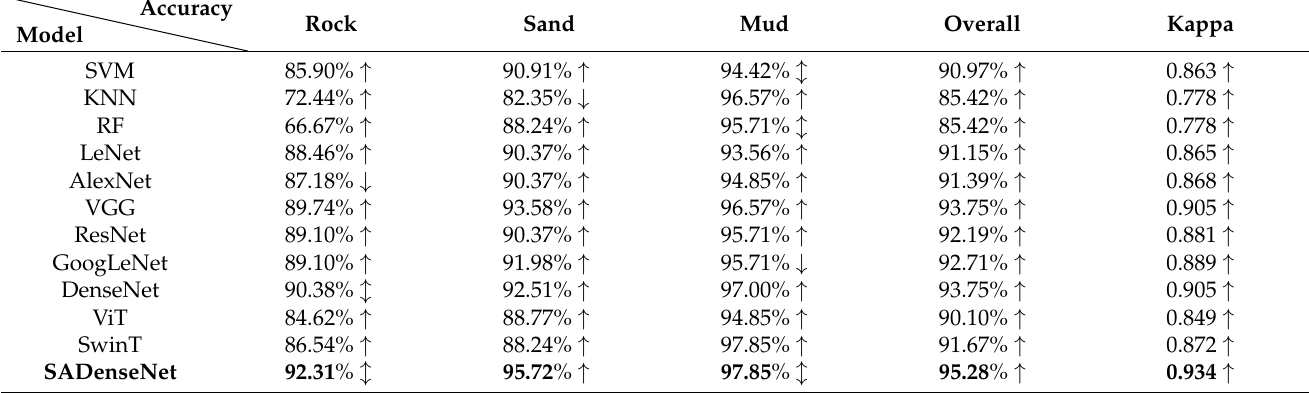
Table 9. Classification accuracy and kappa coefficients of different classifiers trained with the augmented training set. ↑ , (cid:108) , and ↓ mean increase, remain the same, and decrease,